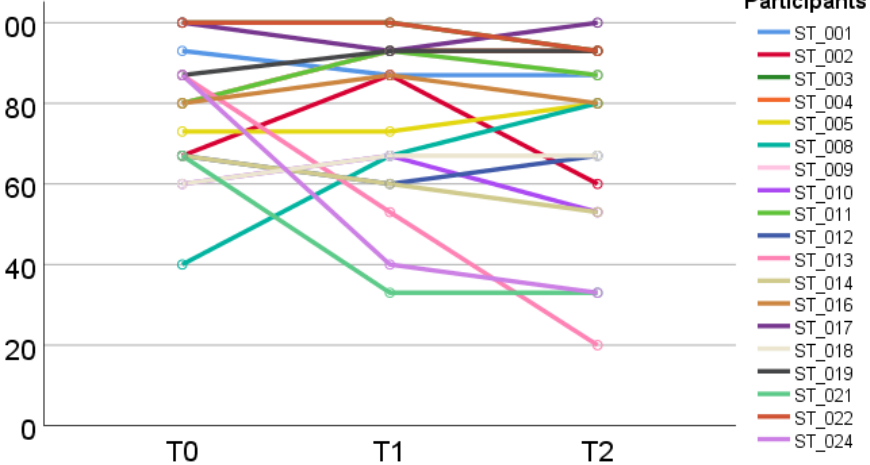
Figure 2. Individual development of physical function (EORTC QLQ-C30) from baseline (T0) to post-assessments (T1) and follow-up (T2).